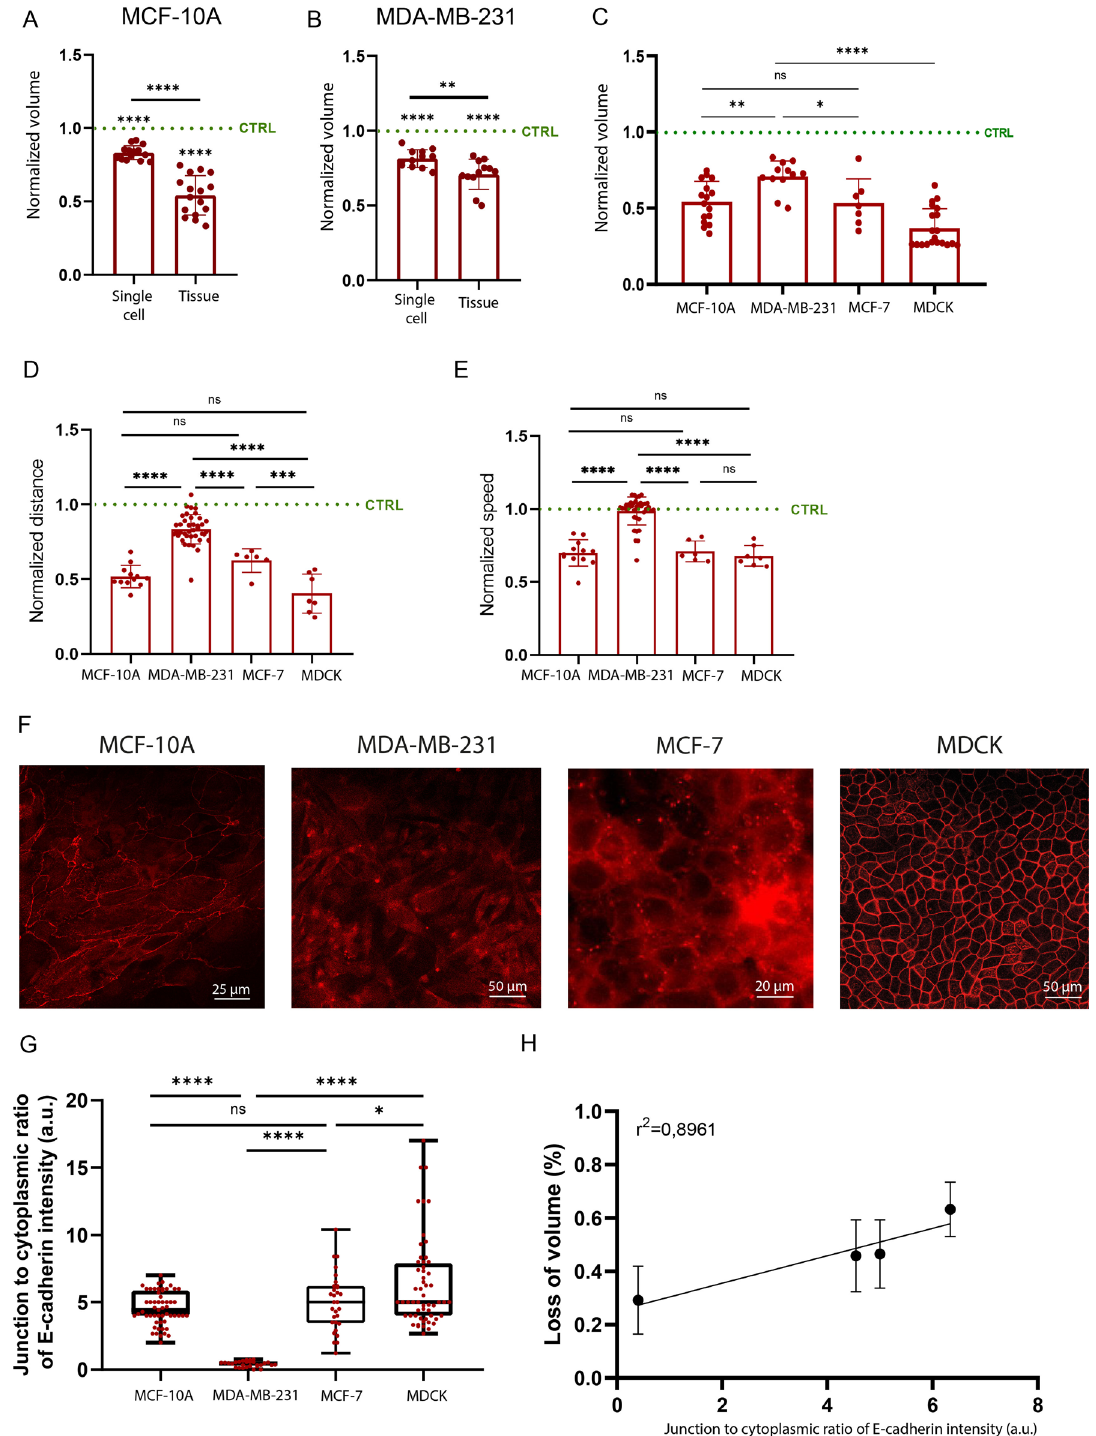
Figure 4. The establishment of cell–cell interactions modulates the volume loss in response to osmotic stress. Comparison of the cell volume of single cells and micropatterned tissues for ( A ) MCF-10A and ( B ) MDA-MB-231 treated with PEG 2.5%. For each cell type, the volumes of PEG-treated tissues are normalized by the volume of micropatterned tissues in isotonic condition. ( C ) Comparison of Normalized volume treated with PEG 2.5% for MCF-10A, MDA-MB-231, MCF-7 and MDCK. For each cell type, the volumes of PEG-treated tissues are normalized by the volume of micropatterned tissues in isotonic condition. ( D ) Normalized maximum distance and ( E ) normalized speed of MCF-10A, MDA-MB-231, MCF-7 and MDCK cells. For each cell type, maximal distances of migration or speed are normalized by maximum distance of migration or speed of control cells. ( F ) Staining of E-cadherin for of MCF-10A, MDA-MB-231, MCF-7 and MDCK cells. ( G ) Quantification of the junction to cytoplasm ratio of E-cadherin intensity for of MCF-10A, MDA-MB-231, MCF-7 and MDCK. ( H ) Linear relation (R 2 = 0.8961) between the cell volume loss (%) and the junction to cytoplasm ratio of E-cadherin intensity. Cells exhibiting higher cadherin fluorescence intensity show larger volume